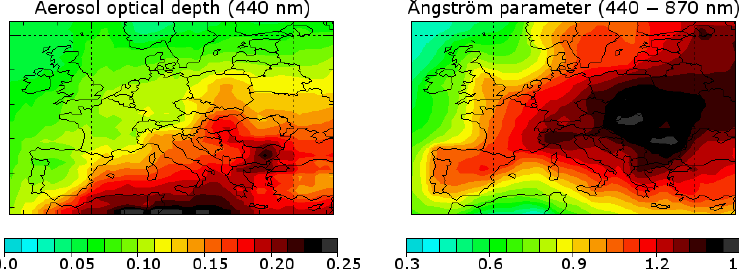
Fig. 2. Modelled optical properties of the atmospheric column averaged over